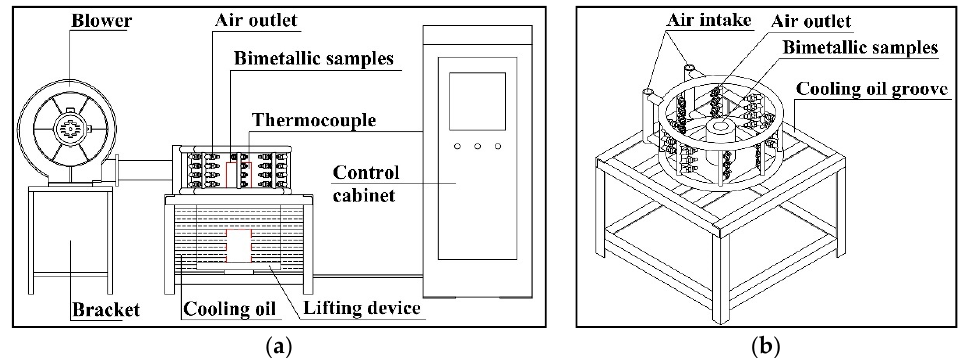
through cooling the oil rapidly solidification occurs to obtain bimetal samples.